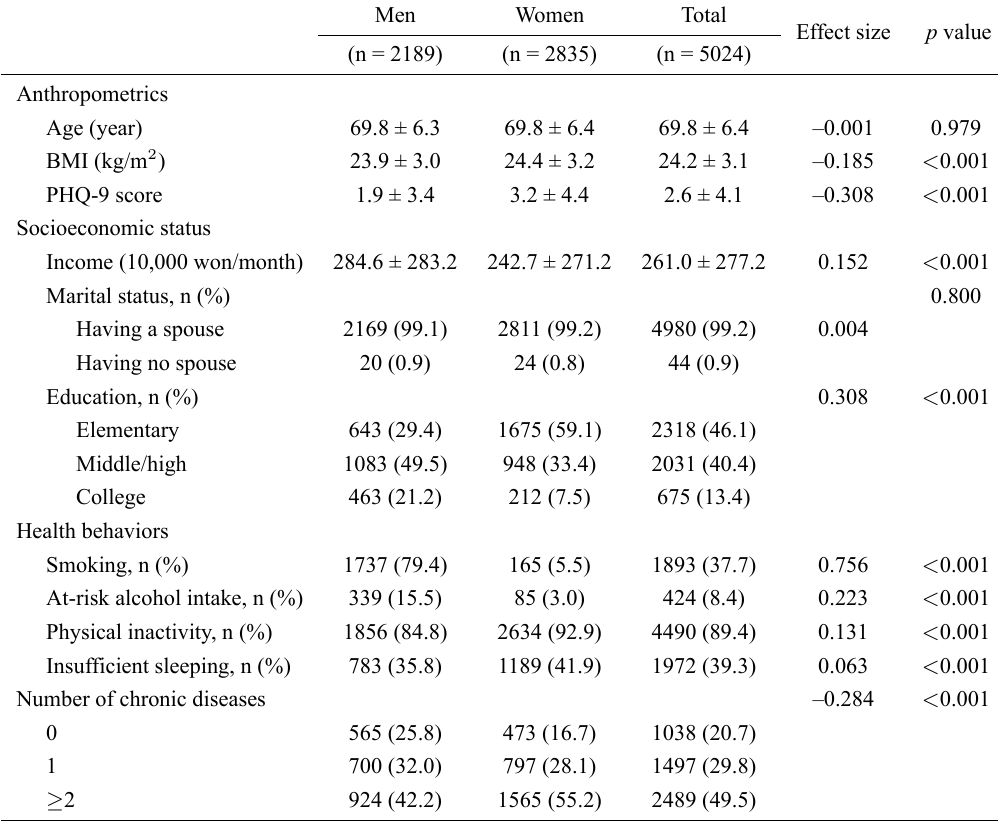
Table 1. Description of study